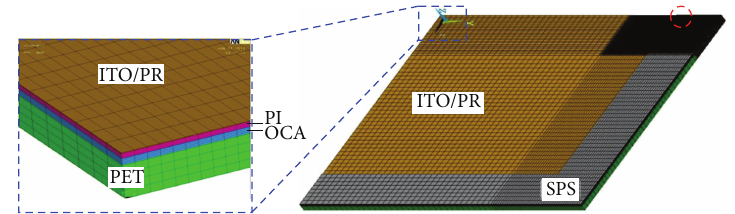
Figure 3: 3D FE model of the flexible TDP structure with a side protection structure (SPS).